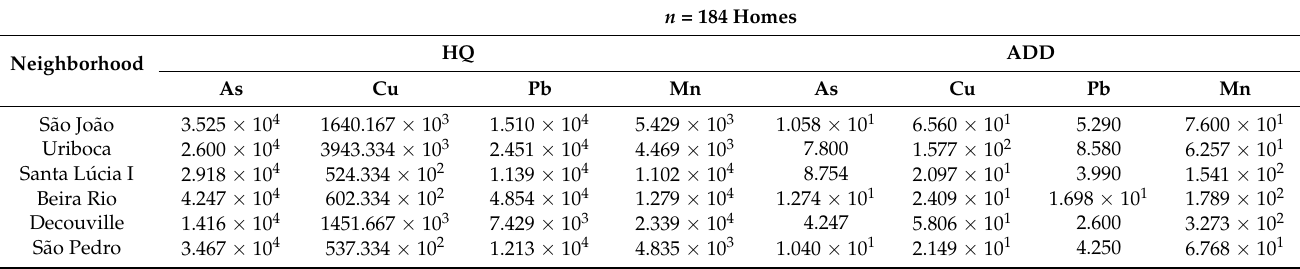
Table 5. Non-carcinogenic risk, mean values (mg.kg − 1 /day), risk quotient (HQ) and average daily dose (ADD) in the groundwater of Marituba, Amazonia, Brazil, 2019. n = 184